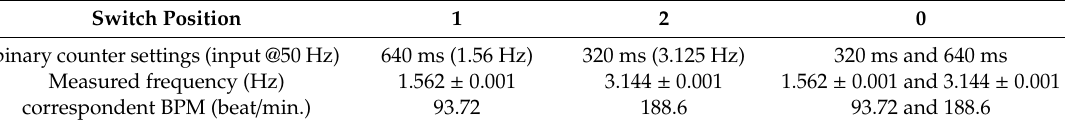
Table 1. Measured parameters of FHRS on